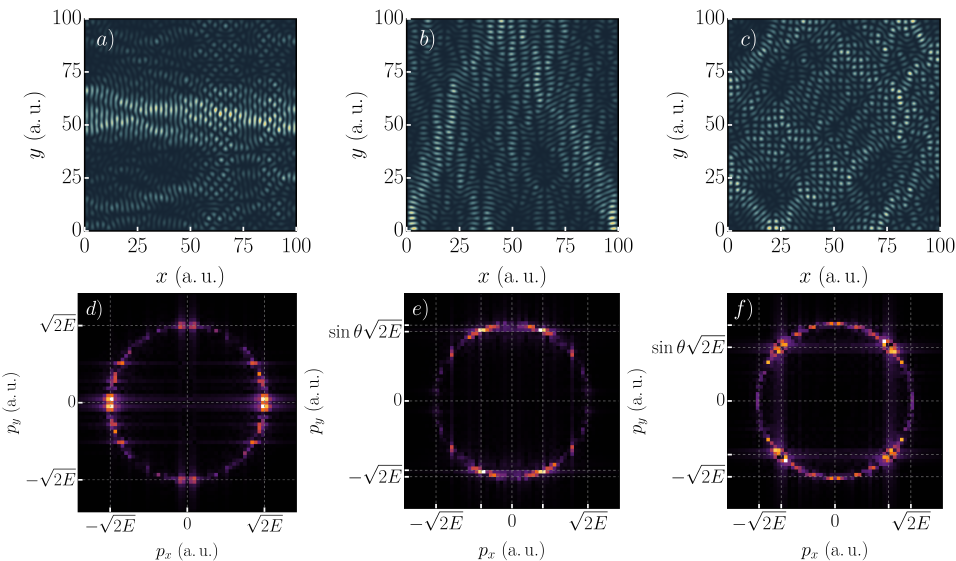
Figure 3. Three scarred eigenstates of a square with a size of 100 × 100a.u., α = 25meVÅ, B = 100mT, ten impurities of strength M = 0.18a.u. and FWHM = 2.6a.u., with Dirichlet boundary conditions. Lighter colors represent higher density, while the background color (blue for a – c and black for d – f ) means zero density. In each panel ( a – c ), at least one prominent path is visible. The 2834th ( a ), 2887th ( b ), and 2949th ( c ) states are shown with energies of 0.91, 0.93, and 0.95a.u. In Panel ( c ), two paths parallel to the diagonals are visible. The wave functions in the momentum space for the states are shown in Panels ( d – f ).